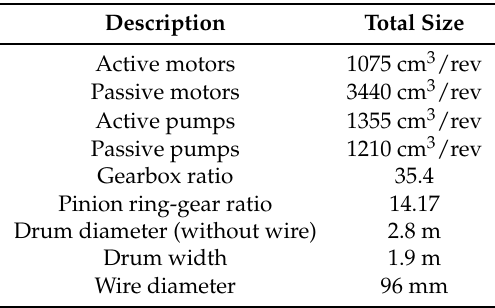
Table 1. Main component data.